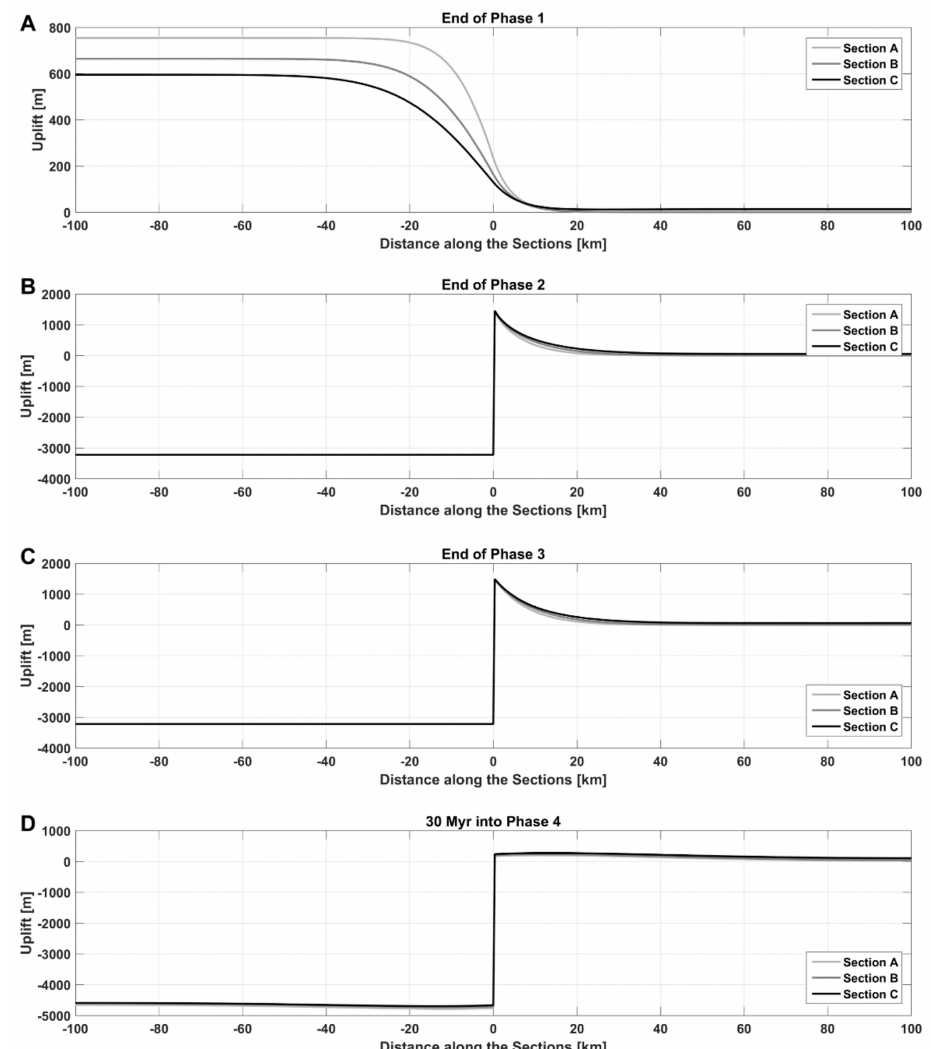
Figure 12. Uplift generated in the lithosphere along sections A, B, and C at the end of various phases along the transform margin for the reference case with sediments. Sub-figures A to D denote transform phases 1 to 4 (see